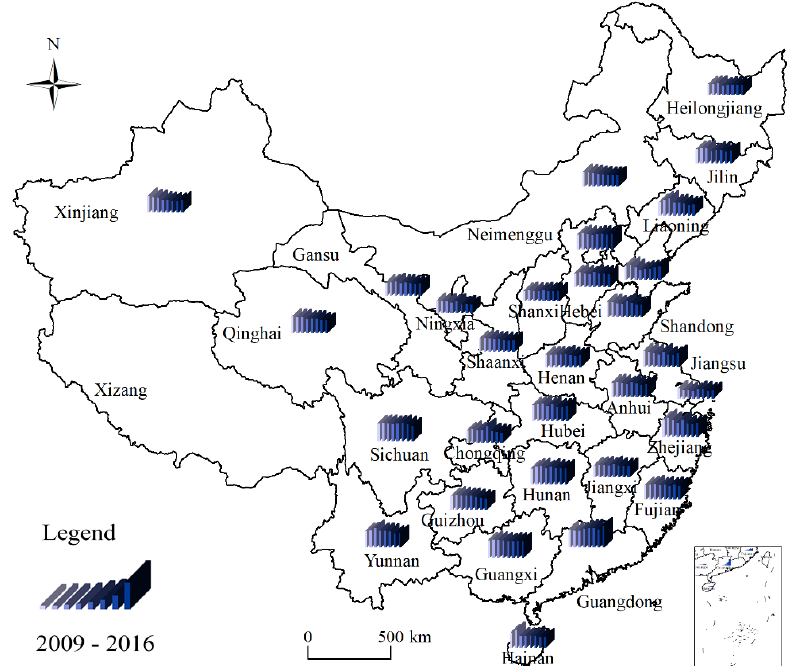
Figure 8. The spatial pattern and temporal evolution of land finance risks from 2009 to 2016.